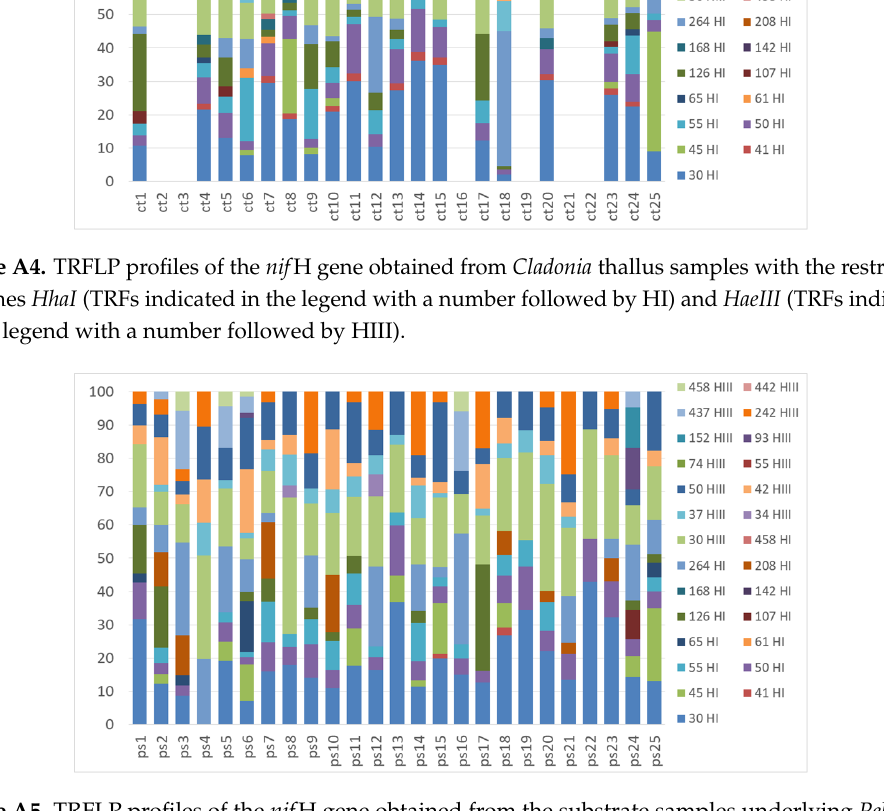
Figure A5. TRFLP profiles of the nif H gene obtained from the substrate samples underlying Peltigera lichens with the restriction enzymes HhaI (TRFs indicated in the legend with a number followed by HI) and HaeIII (TRFs indicated in the legend with a number followed by HIII).